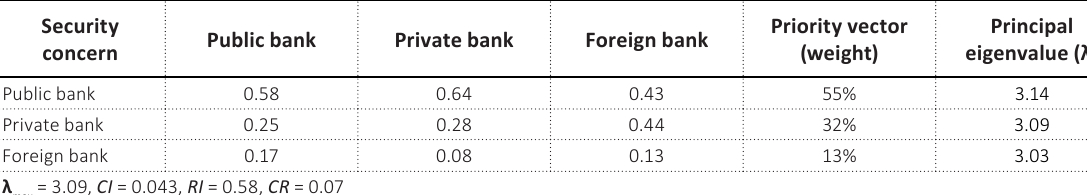
Table 9. Normalized weighted scores of various aspects of security Security